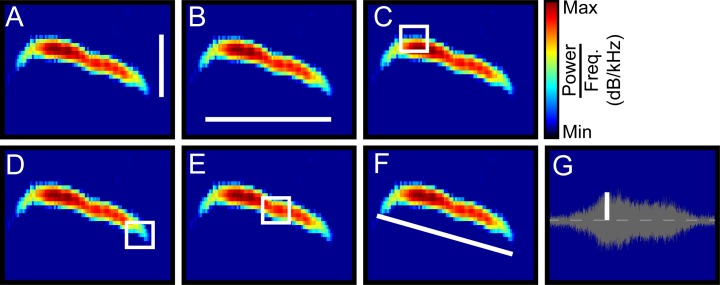
Features of vocal signals.To compare male and female vocal signals, bandwidth (A), duration (B), high frequency (C), low frequency (D), mean fundamental frequency (E), and change in frequency (F) were measured from a single spectrogram. The x- and y-axes represent time and frequency, respectively. The voltage trace (G) was used to quantify amplitude, with x- and y- axes representing time and voltage, respectively. The white lines or boxes indicate the quantified features.